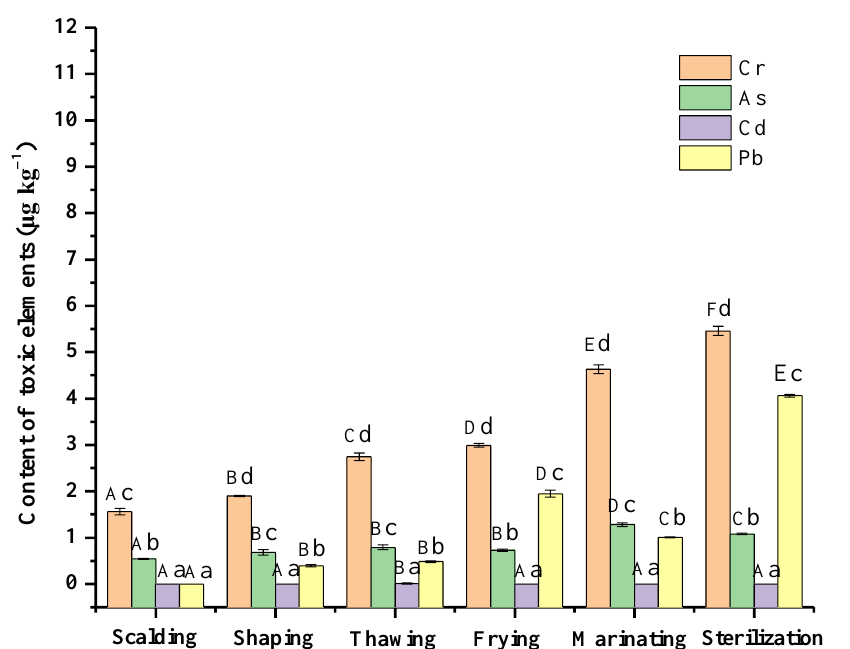
Figure 3. Toxic elements in chicken during the processing stage. (Capital letters indicate significant differences in the content of the same element in the different processing stages. Small letters indicate significant differences in the content of different elements in the same processing stage).